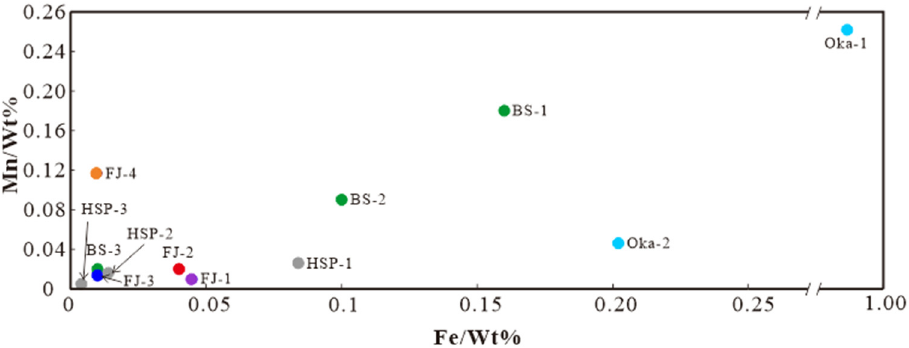
Figure 7. Fe-Mn diagram of Fujian calcite samples.